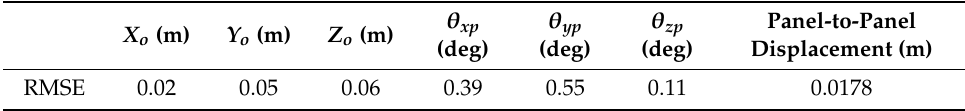
Table 8. RMSE of the di ff erences between the TLS-based and MLS-based serviceability measures for the MSE wall at Site-1.